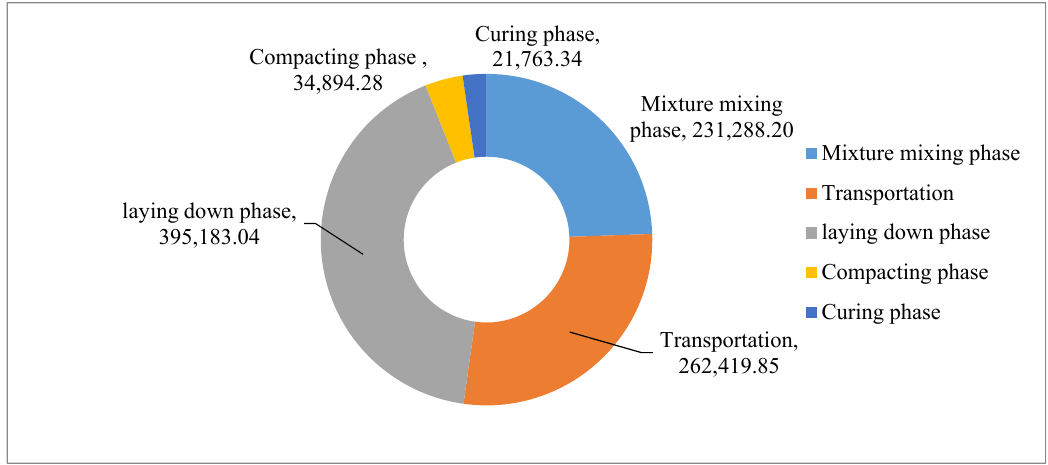
Figure 10. CO 2 e emission of different phases in cement-stabilized course construction excluding raw materials production process (unit: kg).